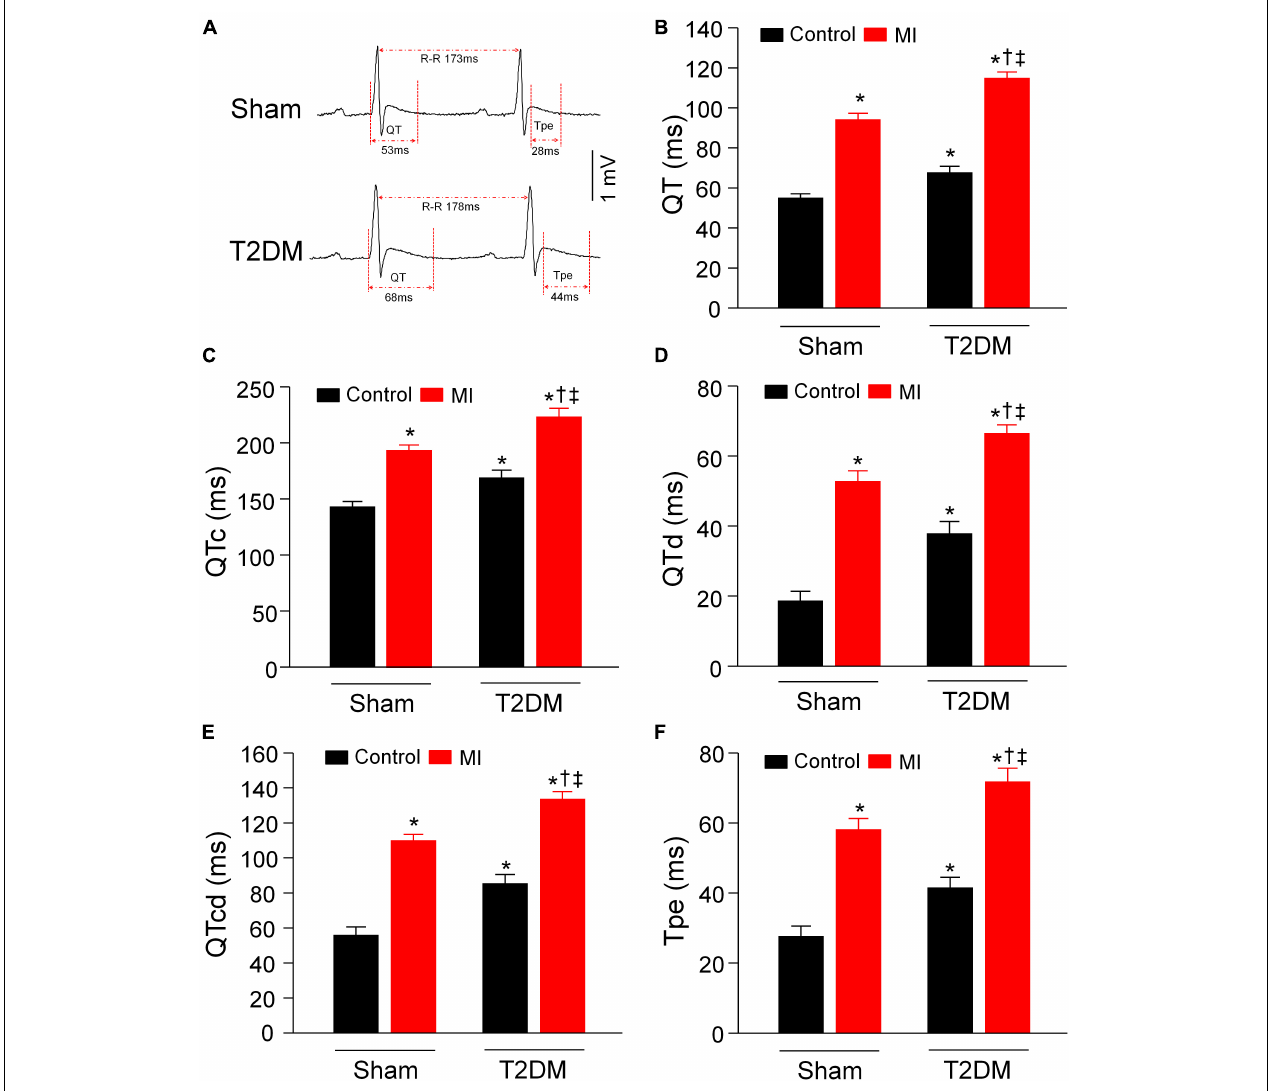
FIGURE 4 | Heterogeneity of ventricular electrical activities calculated from 24-h ECG recording in all experimental groups of conscious rats. (A) : Representative tracings for QT and Tpe intervals in sham (upper) and T2DM (lower) rats. (B–F) : Quantitative data for QT interval (B) , QTc interval (C) , QT dispersion (D) , QTc dispersion (E) , and Tpe (F) in all experimental groups. T2DM significantly increased the heterogeneity of ventricular electrical activities, compared to sham rats without MI. MI-induced alterations in the heterogeneity of ventricular electrical activities were more obvious in T2DM rats, compared with sham+MI. Data are means ± SEM; n = 6 rats per group. Statistical significance was determined by one-way ANOVA with post-hoc Bonferroni test. * P < 0.05 vs. sham; † p < 0.05 vs. T2DM; ‡ p < 0.05 vs. sham+MI.